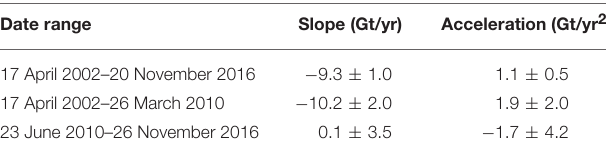
TABLE 4 | Ice mass trends and accelerations over Iceland before and after the 2010 Eyjafjallajòkull eruption. Date